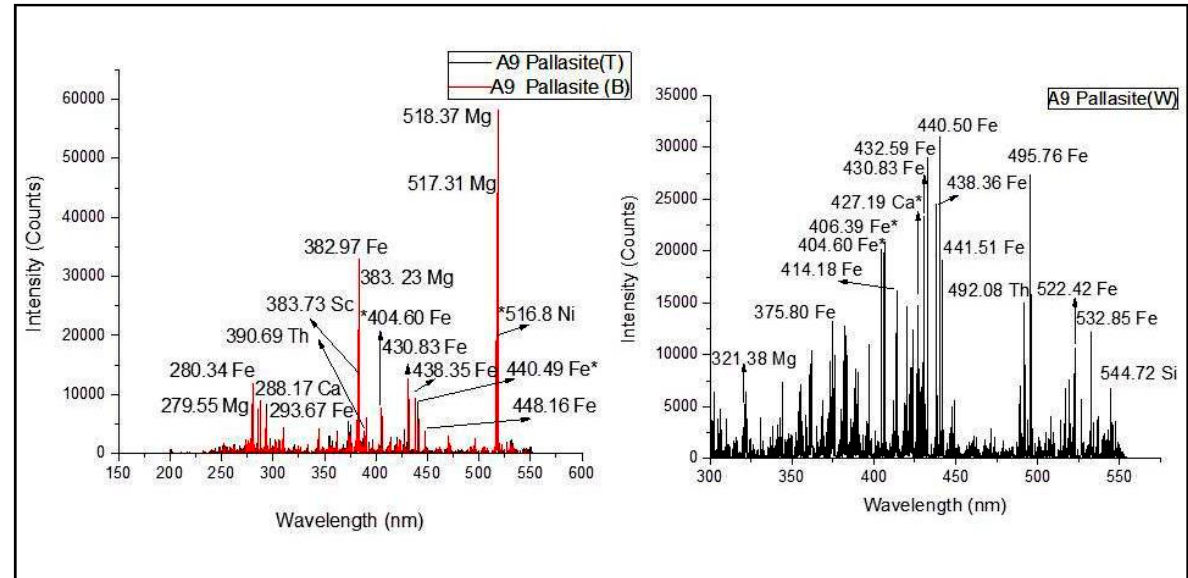
Figure 11. Overlaid LIBS spectra of Samples A9 (T) and A9 (B) and the LIBS spectrum of A9 (W). In pallasite (T) and pallasite (B), iron lines are observed at 430.83 nm, 438.35 nm, 440.49 nm, 404.60 nm, 382.97 nm and so on. Magnesium lines can be seen at 518.37nm, 517.31 nm, 383.23 nm and 279.54 nm. Nickel and calcium lines can be observed at 516.80 nm and 288.17 nm, respectively.